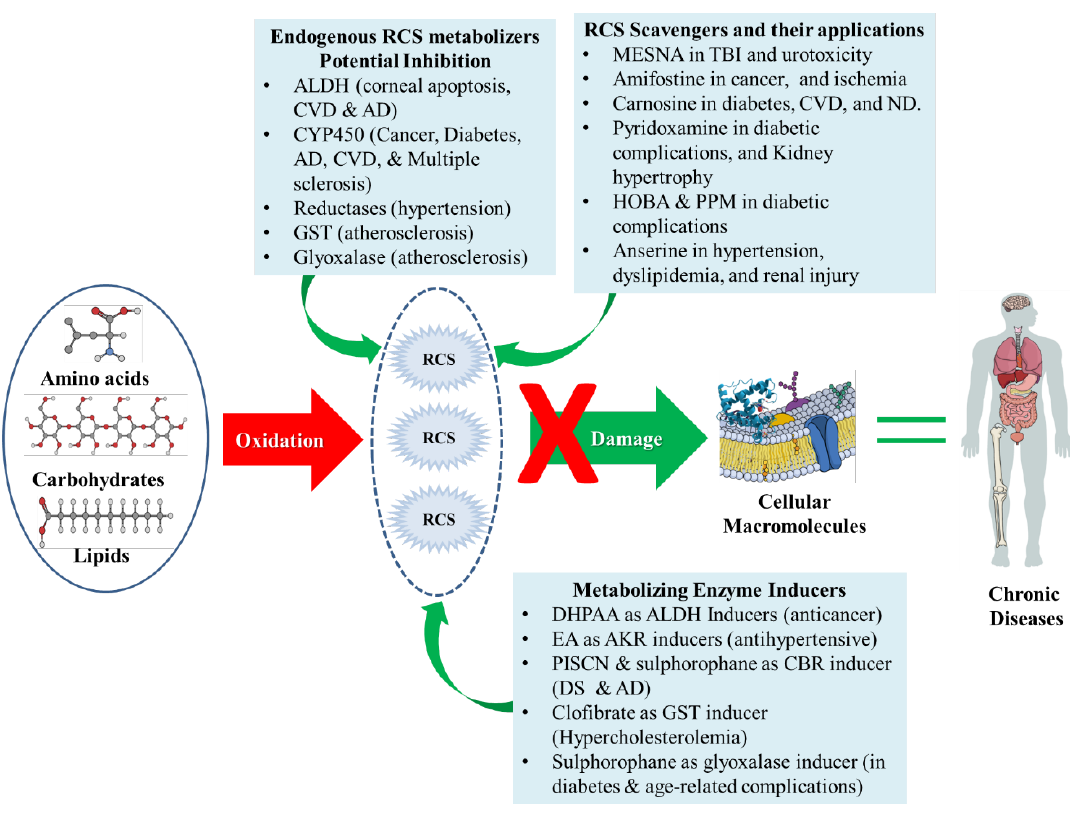
Figure 4. Approaches to counteract RCS at different levels.